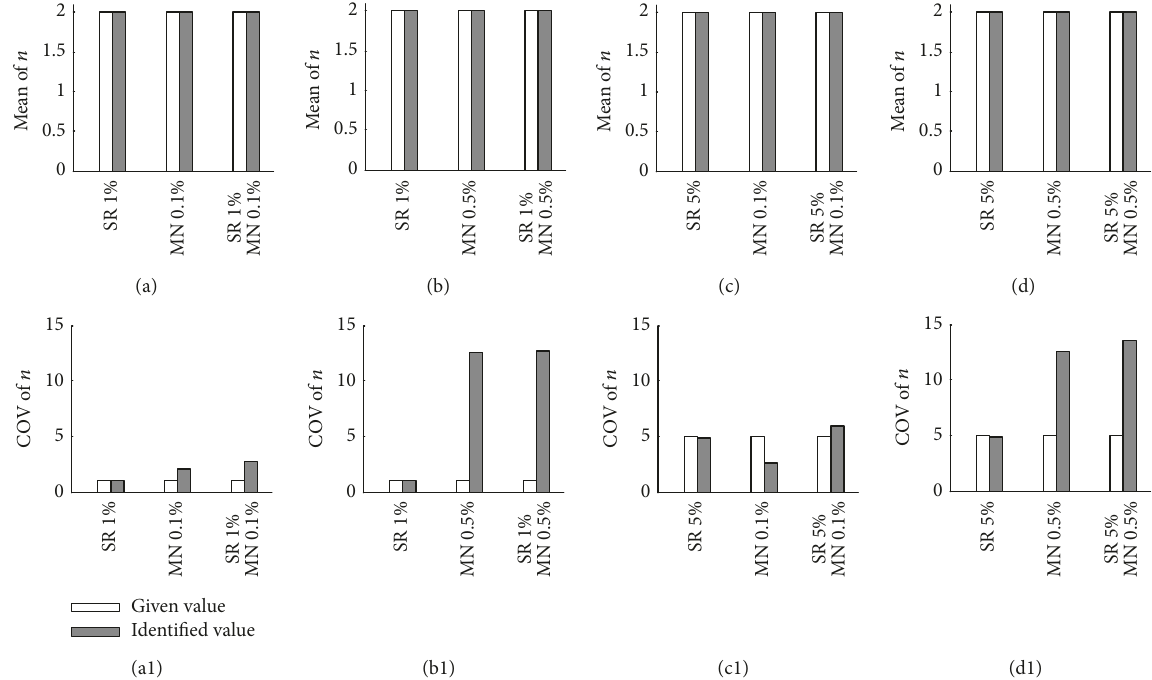
Figure 9: Means and COVs of volume fraction index ( 𝑛 ) for FGM along axial direction with different uncertainties.